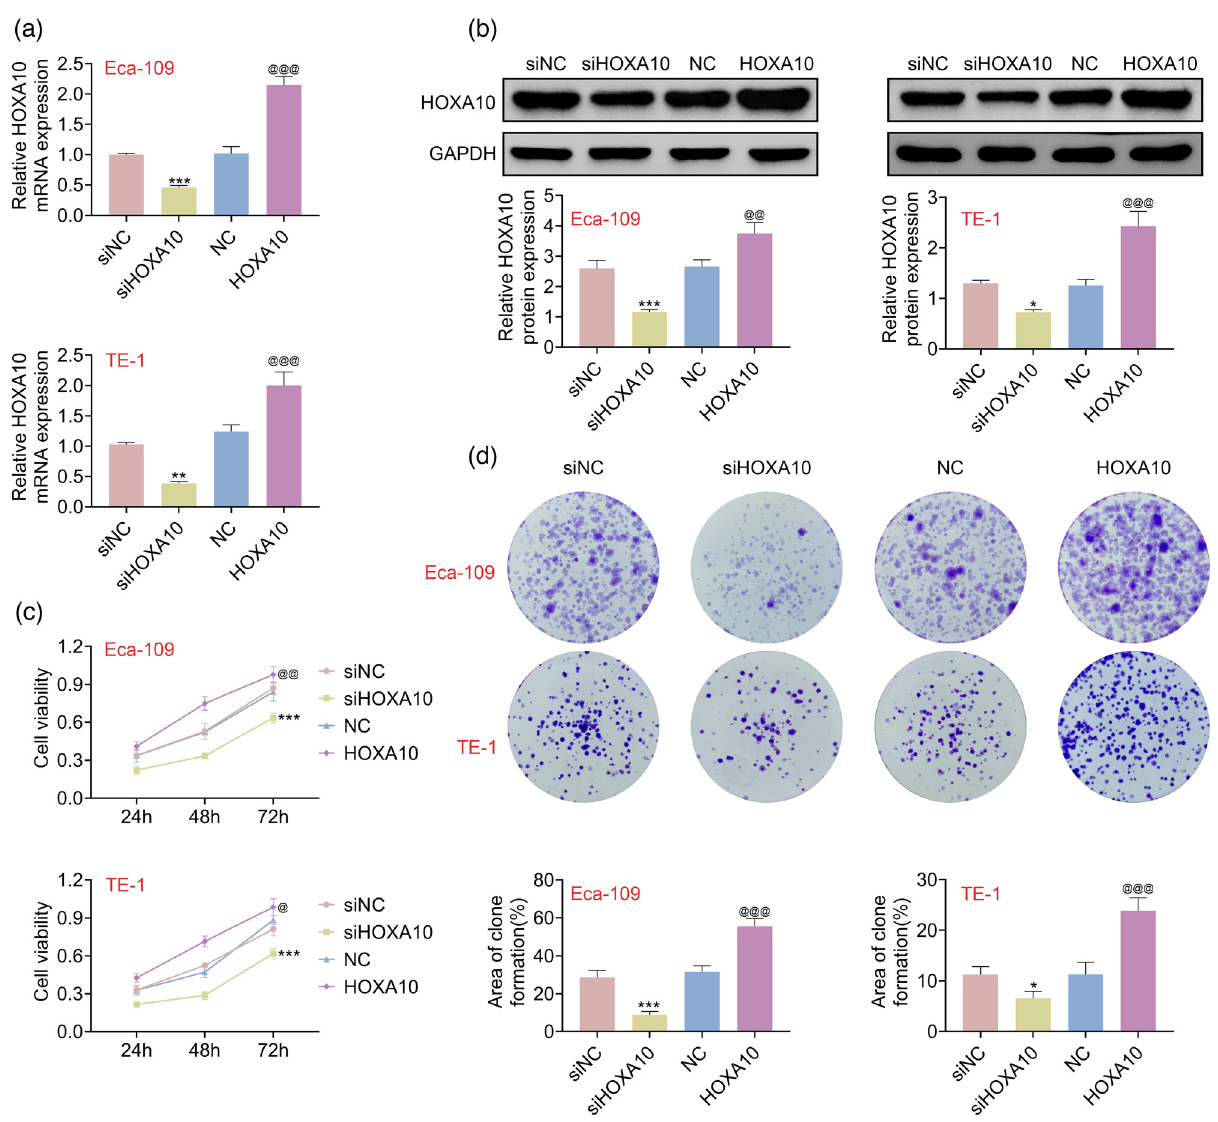
Figure 2: Overexpression of HOXA10 enhanced proliferation in EC cells. ( a ) Real - time PCR showed HOXA10 mRNA level in Eca - 109 and TE - 1 cells. ( b ) Western blot showed HOXA10 protein level in Eca - 109 and TE - 1 cells. ( c ) CCK - 8 assay revealed that the elevation of cell viability was caused by HOXA10 overexpression and inhibition of cell viability was induced by HOXA10 knockdown. ( d ) Clone formation assay determined that HOXA10 overexpression increased the colony number and HOXA10 knockdown suppressed the colony number. Each experiment repeated three times. ** p < 0.01, *** p < 0 .001 vs NC. @@ p < 0.01, @@@ p < 0.001 vs